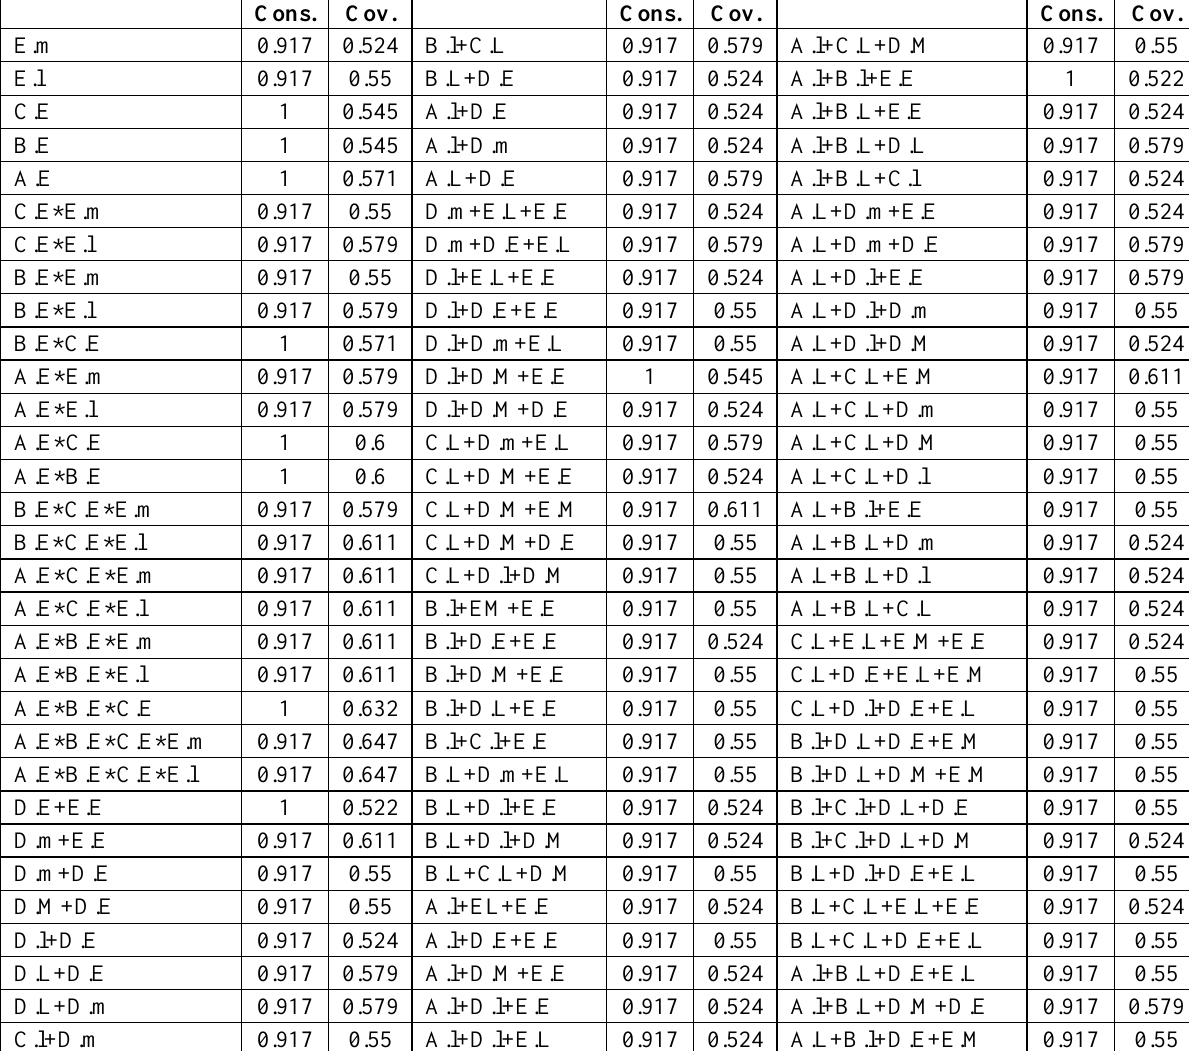
Table A3.9. Results of the csQCA for the analysis of necessity for the group success. To simplfy the table, the role of observer and the role of enforcer in positions A, B, and C were not included. Cons.=Consistency, Cov.=Coverage, L=Leader, K=Knowledge generator, C=Connector, F=Follower, M=Moralist, E=Enforcer, O=Observer, A.=Player in position A, B.=Player in position B, C.=Player in position C, D.=Player in position D, E.=Player in position E. Cons. Cov. Cons. Cov. Cons.